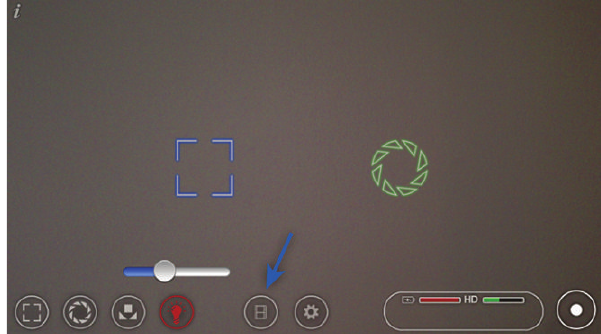
Figure 1: Filmic Pro app allows independent control of light inten- sity (red light bulb), exposure (green circle), and focus (blue square) while filming. Video library access (blue arrow).